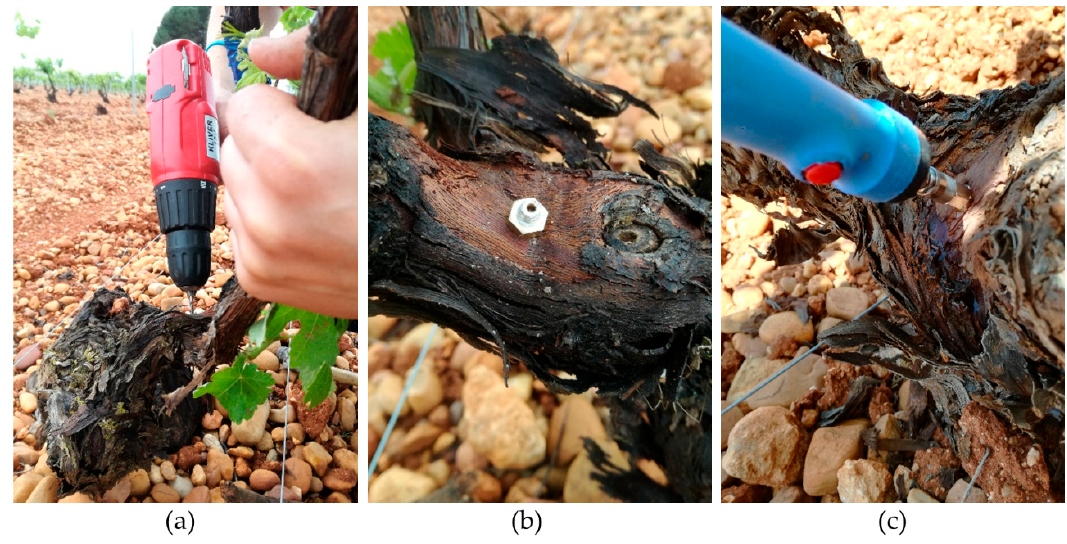
Figure 1. Procedure for the application of ozonated water through endotherapy: ( a ) Drilling of the trunk; ( b ) Insertion of the cannula; ( c ) Placement of the connector to the ozonated water tank.